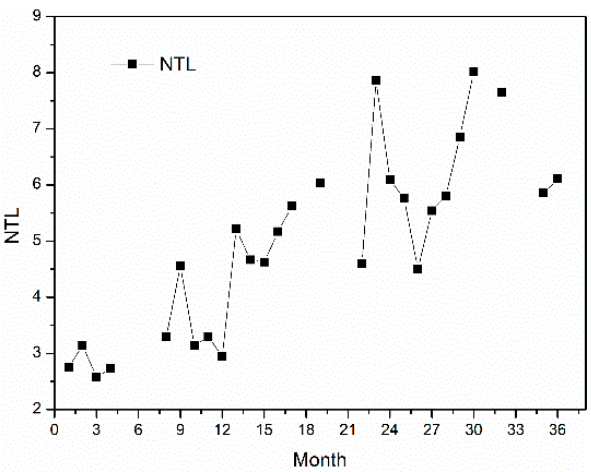
Figure 8. The monthly mean nighttime light values of Sihanouk Port Special Economic Zone, Cambodia, from January 2018 to December 2020.